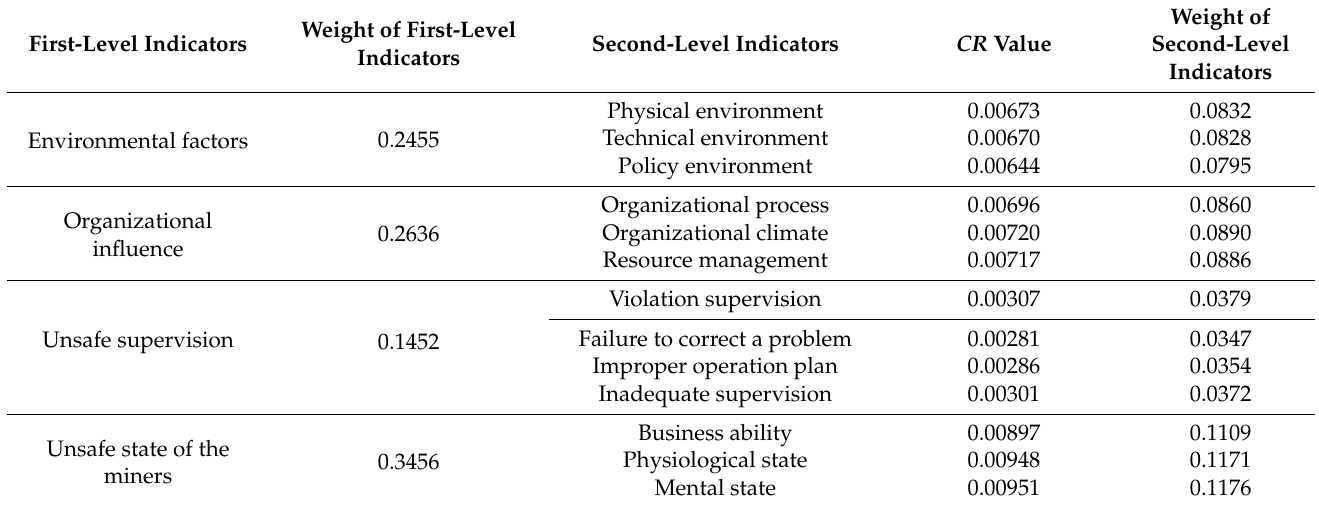
Table 12. Index weights of risk factors for unsafe behaviors of deep coal